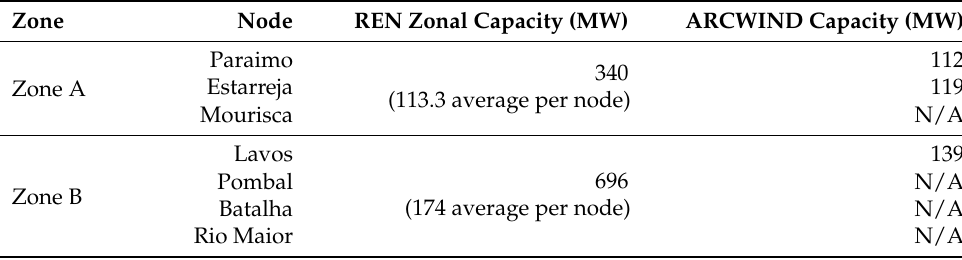
Table 8. Nodal capacity calculation in Portugal: comparison with REN